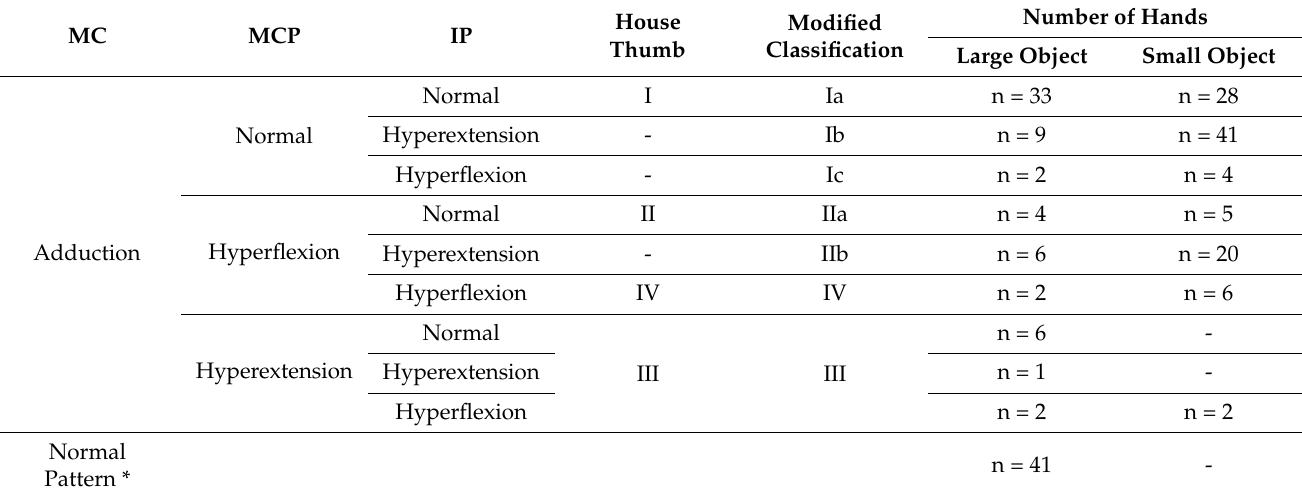
Table 2. Thumb-in-palm pattern when grasping large or small